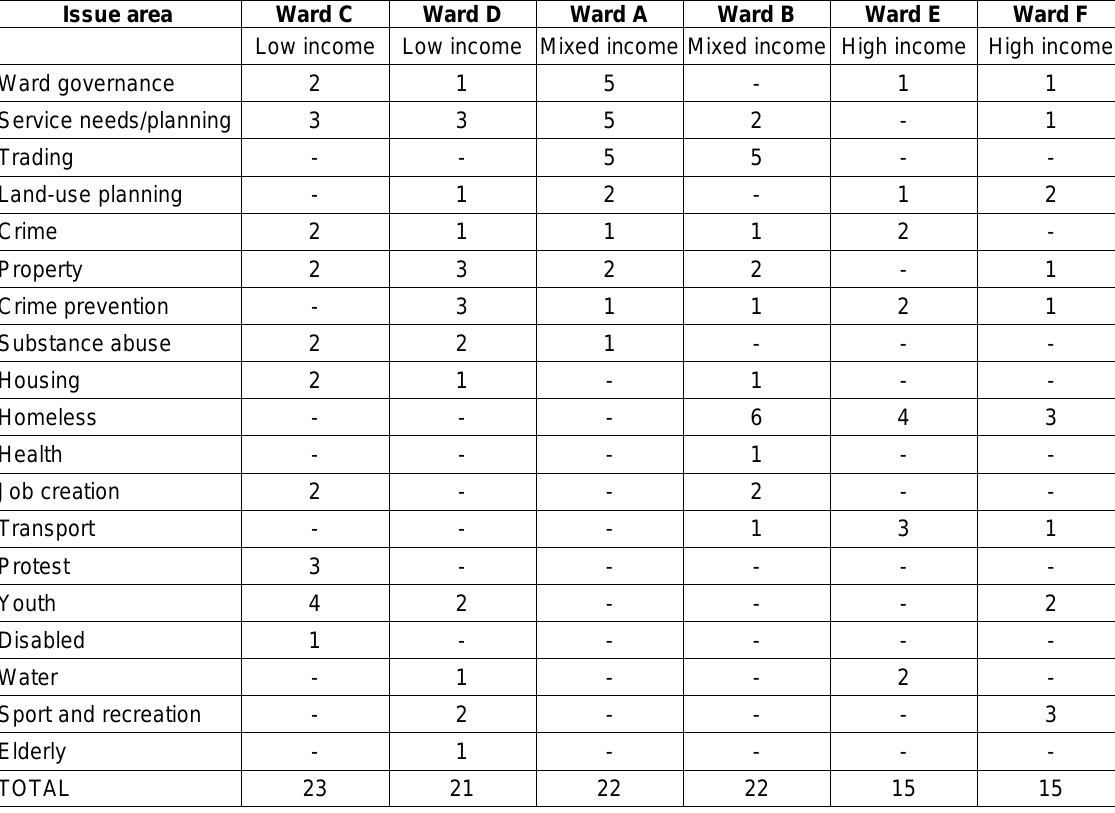
Table 2: Issue areas by sampled wards in community media coverage Issue area